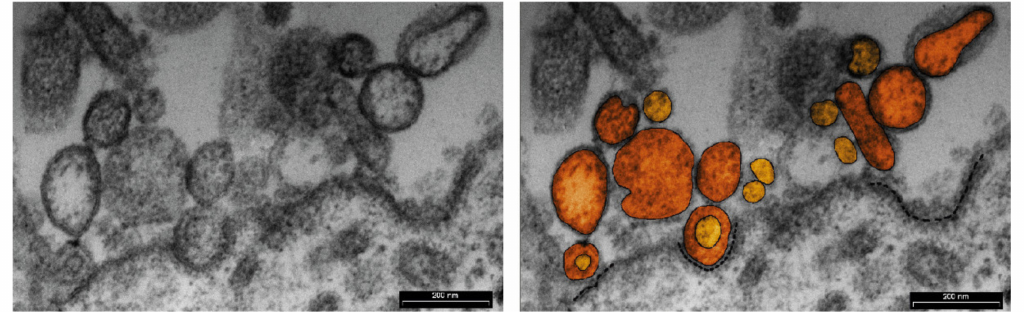
Figure 1. Uptake of EVs via clathrin-maintained endocytosis by trophoblast cell on day 16 of pregnancy. Two types of EVs internalized by endocytosis are located in the extracellular space.